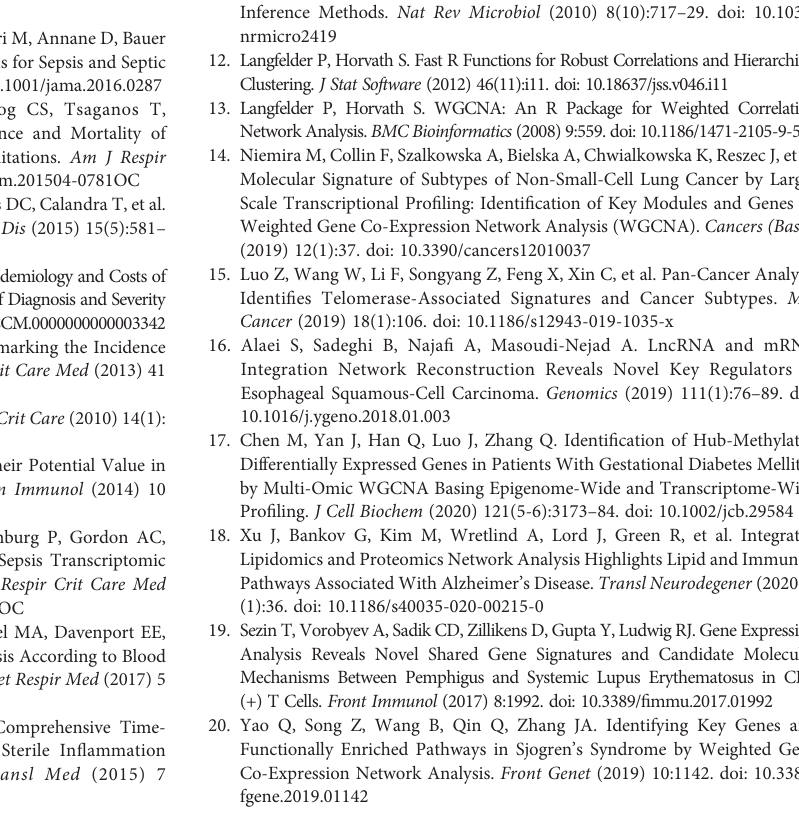
Supplementary Figure 1 | Distribution of average gene expression signi fi cance and errors in the modules associated with sepsis outcome. Supplementary Figure 2 | The network contains the top 20 genes in the MCC of the M6 module. The gradation of the color represents the MCC score and the width represents the weight of each two nodes. Supplementary Figure 3 | (A) Representative photomicrographs showing EGFP from mice treated with PBS, AdCon and AdSdf4. (B) Representative photomicrographs showing Sdf4 (red), DAPI (blue) and their merged images from mice treated with PBS, AdCon and AdSdf4. (C) Representative western blot results from mice treated with PBS, AdCon and AdSdf4 for levels of Sdf4 and b -actin. (D) The Sdf4 bands were quanti fi ed by densitometry and normalized to the density of b -actin. n=5. Data were shown in Mean ± SD. **p <